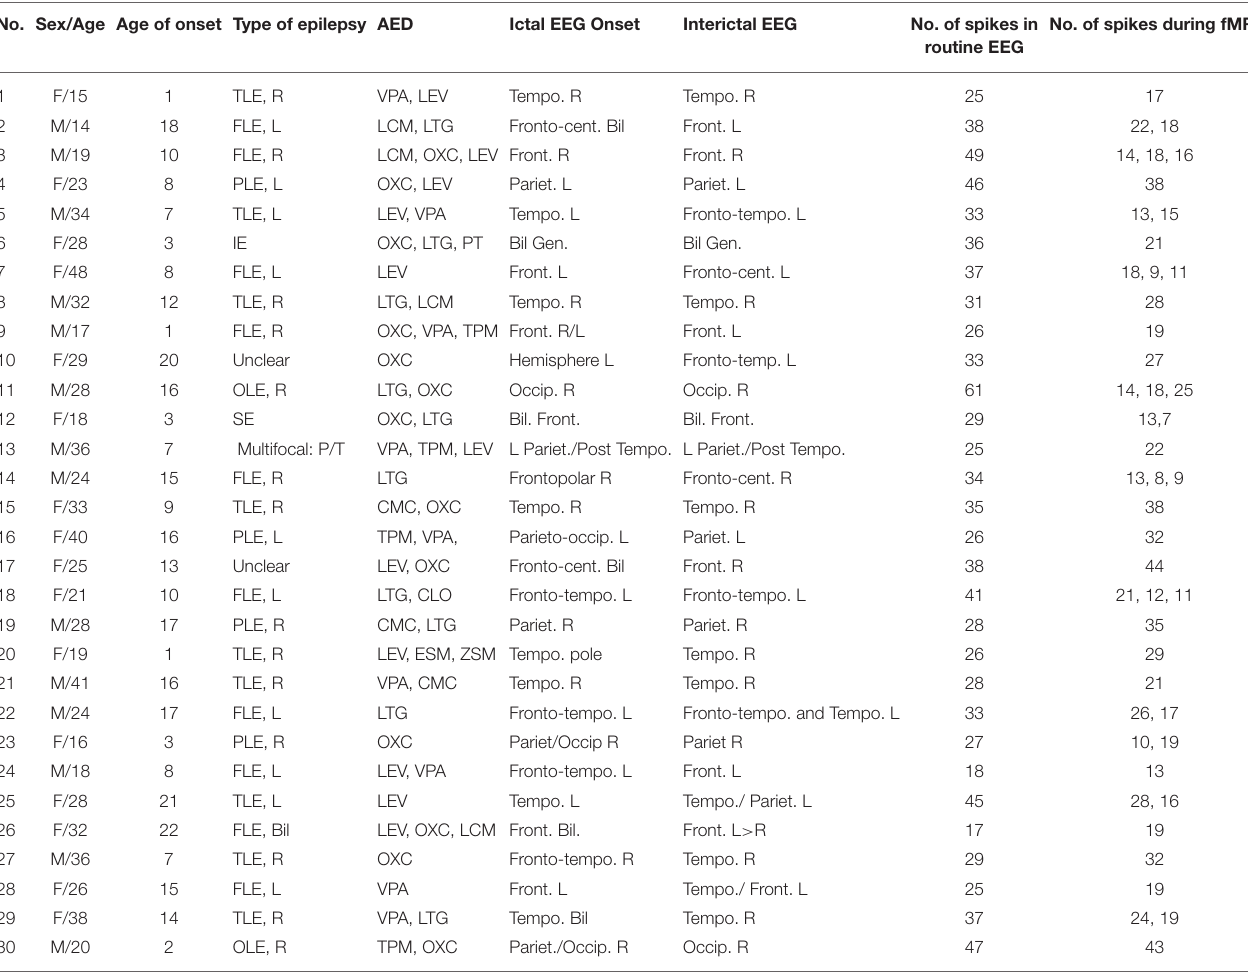
TABLE 1 | Patients clinical